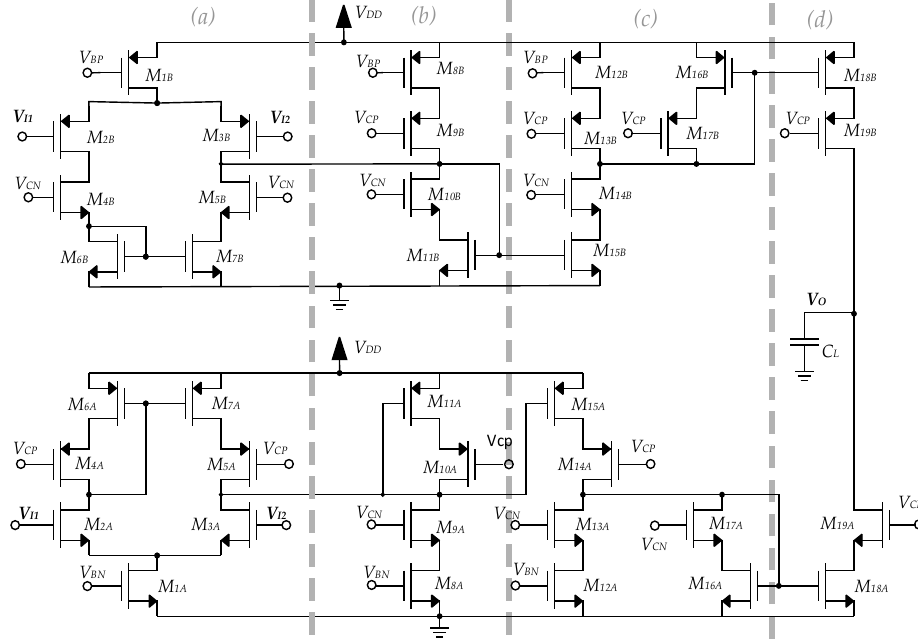
Figure 3. Topology of the proposed amplifier with differential input and single-ended output.